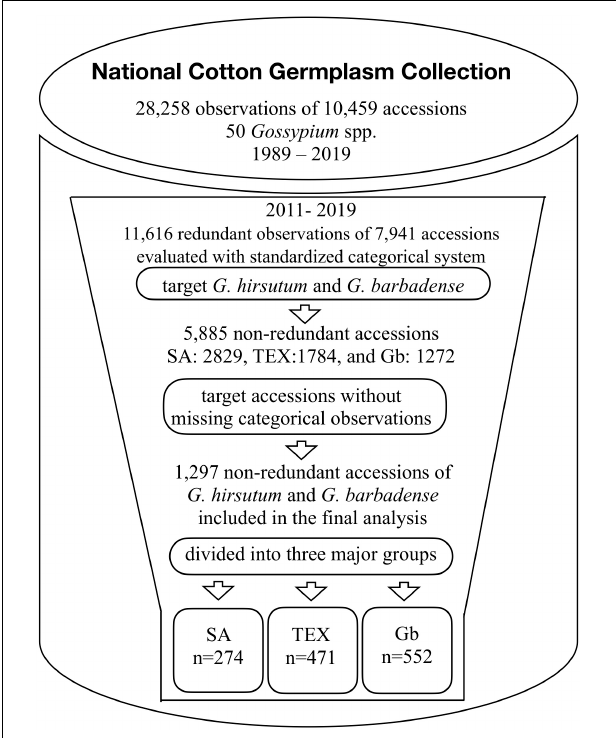
FIGURE 2 | Summary of the workflow leading to the final categorical trait descriptor dataset. Redundant observations reflect multiple evaluations of a single accession in multiple locations and/or different years. The data collected from 2011 to 2019 contained 11,616 field observations of approximately 21 Gossypium spp. Our work focused on data subsets enriched in G. hirsutum (Gh) and G. barbadense (Gb) accessions: SA, mainly Upland cotton cultivars; TEX, mainly photoperiodic/tropical landraces; and Gb – mainly Pima cotton. Numbers presented are as of May 2019, data is added to the database as it is collected so numbers are always